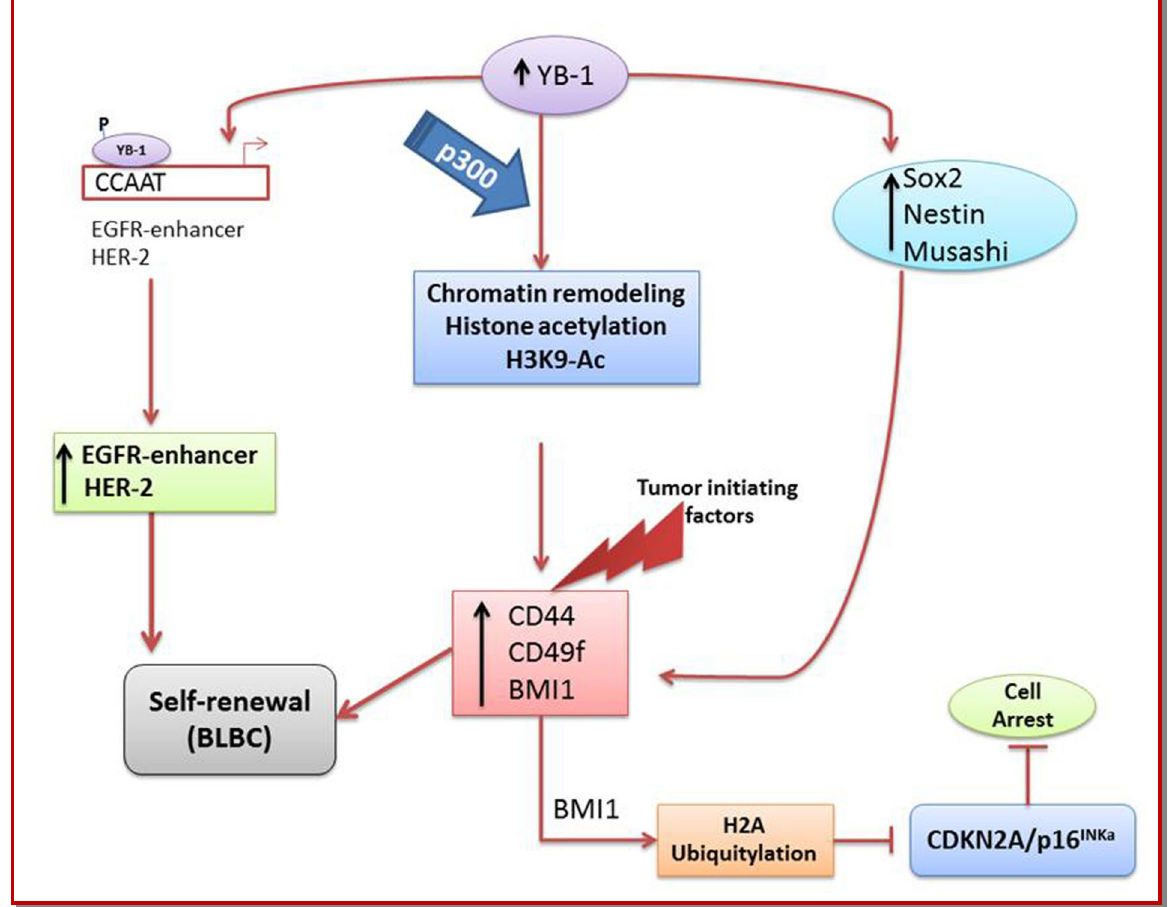
Figure: 2 Role of YB-1 in breast cancer tumor initiation and self-renewal The p300-facilitated chromatin remodeling leads YB-1 binding to TIC-associated gene promoters. BMI1 induction results in his- tone H2A ubiquitylation and repression of CDKN2A (cyclin-dependent kinase inhibitor 2A) locus which is responsible for CDK4 kinase inhibition hence, p16 INK4a mediated cell arrest inhibition. This consequently results in self-renewal and development of BLBC (Davies et al.,